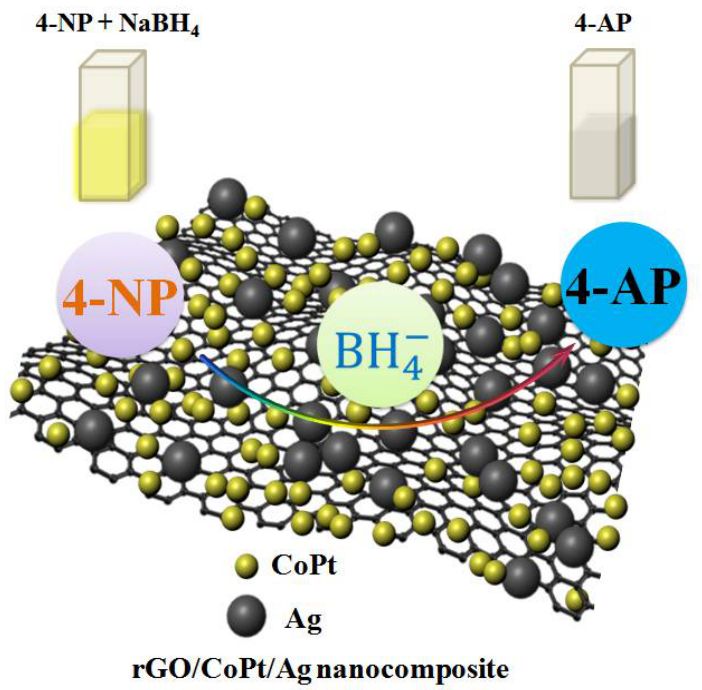
Figure 11. Possible catalytic mechanism for conversion of 4-NP into 4-AP upon the addition of the rGO/CoPt/Ag nanocomposite catalyst with NaBH 4 .